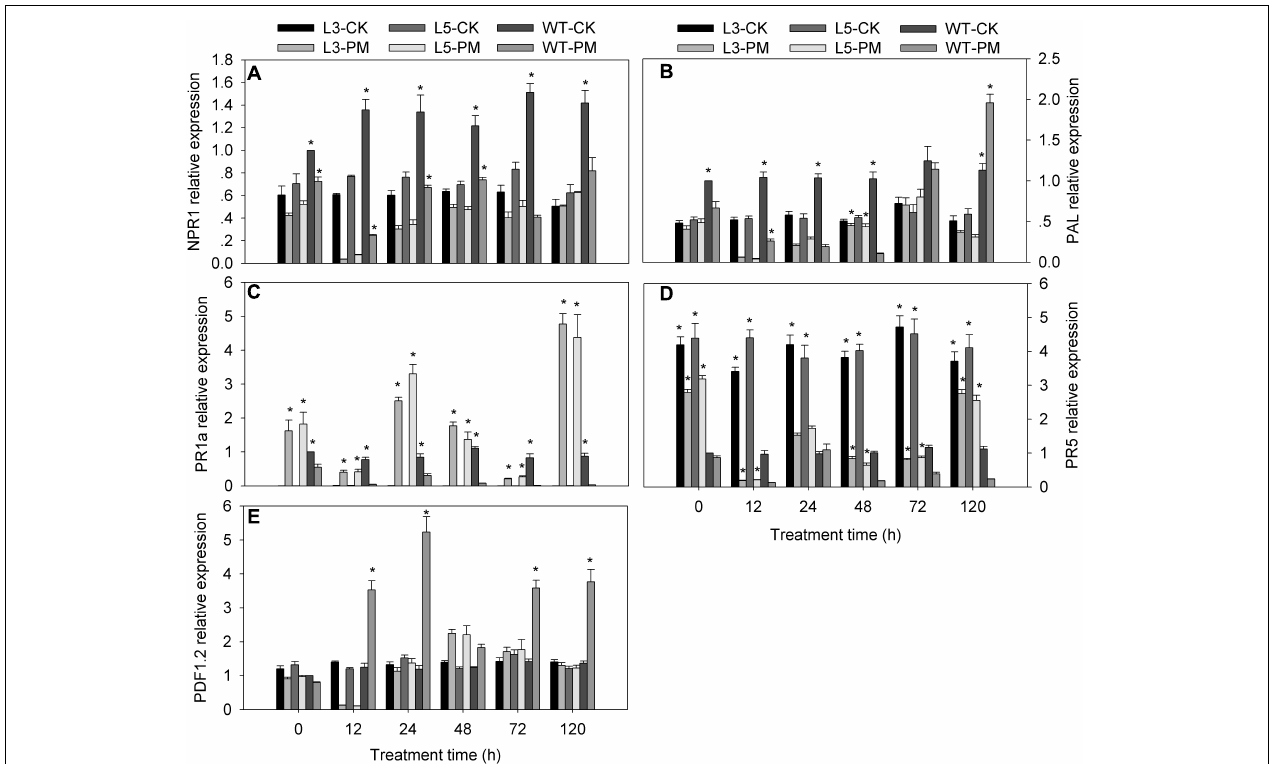
FIGURE 5 | Expression of signal-related genes in transgenic and wild-type plants treated with powdery mildew. The samples of two genetically modified N. benthamiana lines were used to analyze the genes expression by qRT-PCR. (A) NtNPR1 ; (B) NtPAL ; (C) NtPR1a ; (D) NtPR5 ; (E) NtPDF1.2 . L3/5-CK represents transgenic N. benthamiana L3 or L5 line grown under normal conditions; L3/5-PM represents transgenic N. benthamiana L3 or L5 line infected with powdery mildew; WT-CK represents wild-type plants grown under normal conditions; WT-PM represents wild-type plants infected with powdery mildew. N. benthamiana NtEF1- α gene (AF120093) was used as an internal control for normalization of different cDNA samples. The expression levels of signal-related genes in wild-type plants at 0 h were used as control (quantities of calibrator) and were assumed as 1. Three biological triplicates per line were averaged and Bars indicate standard error of the mean. Data between transgenic plants and WT plants (L3/5-PM vs. WT-PM and L3/5-CK vs. WT-CK) were analyzed by one-way ANOVA and “ ∗ ” denotes statistical significance at p <